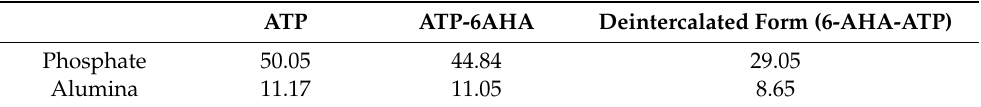
Table 1. Phosphate and alumina composition of ATP, ATP-6-AHA, and its deintercalated form using the XRF technique.